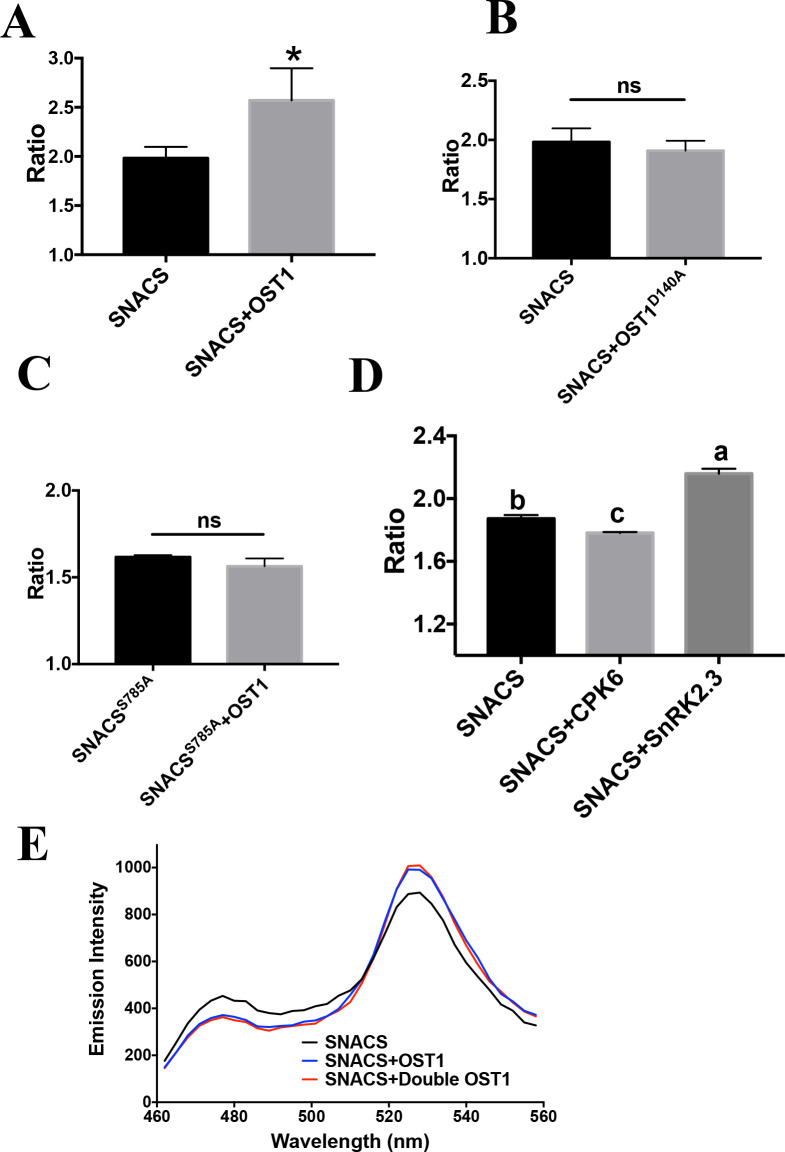
In vitro FRET assay of SNACS reporter.The SNACS protein or the control SNACSS785A isoform was incubated in vitro with GST-OST1, GST-OST1D140A (inactive OST1), GST-CPK6 or GST-SnRK2.3 for 2 hr, respectively. The ratio was calculated from fluorescence intensities of YPet (data points, 525–531 nm) over Turquoise GL (data points, 471–477 nm). (A) and (B) FRET ratios of in vitro FRET assays from three repeats using SNACS. SNACS alone controls in A and B were from the same three experiments shown in the two panels, as experiments were performed in parallel. Error bars denote mean ± SD. n = 3 experiments (*p=0.0418; ns = not significant p=0.4214; Student’s t-test). (C) In vitro FRET assays from three repeats using SNACSS785A. Error bars denote mean ± SD. n = 3 experiments (ns = not significant p=0.115; Student’s t-test). (D) In vitro FRET assays using SNACS with CPK6 or SnRK2.3. Means with different letters are grouped based on one-way ANOVA and Tukey’s test, p<0.05 (n = 3 independent experiments). (E) In vitro FRET assays using SNACS reporter performed in the presence of two concentrations of GST-OST1 (4 µg and 8 µg). Double OST1 denotes 8 µg GST-OST1. Note that the SNACS and ‘SNACS+OST1’ control trace in panel E is the same as the SNACS and ‘SNACS+OST1’ trace in Figure 1D, as these data were obtained within the same data set.Figure 1—figure supplement 1—source data 1.In vitro SNACS FRET ratio values in Figure 1—figure supplement 1.